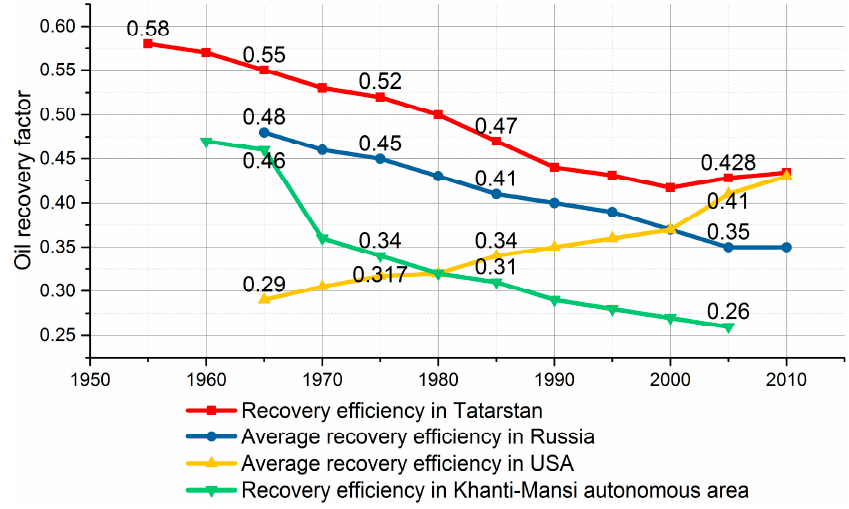
Figure 1. Comparison of oil recovery efficiency in USA and Russia [8].